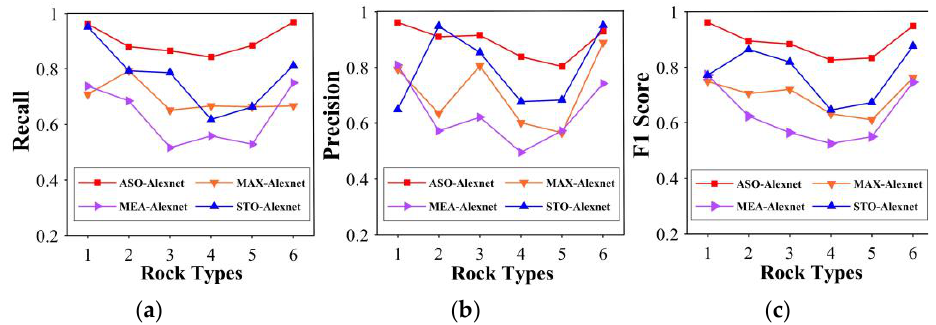
Figure 16. Performance of various rock types evaluated by different metrics, the meaning of digits: 1-wackestone, 2-granite, 3-schist, 4-quartz sandstone, 5-conglomerate, 6-crystalline dolomite. ( a ) Recall rate; ( b ) precision rate; ( c ) F1 score.